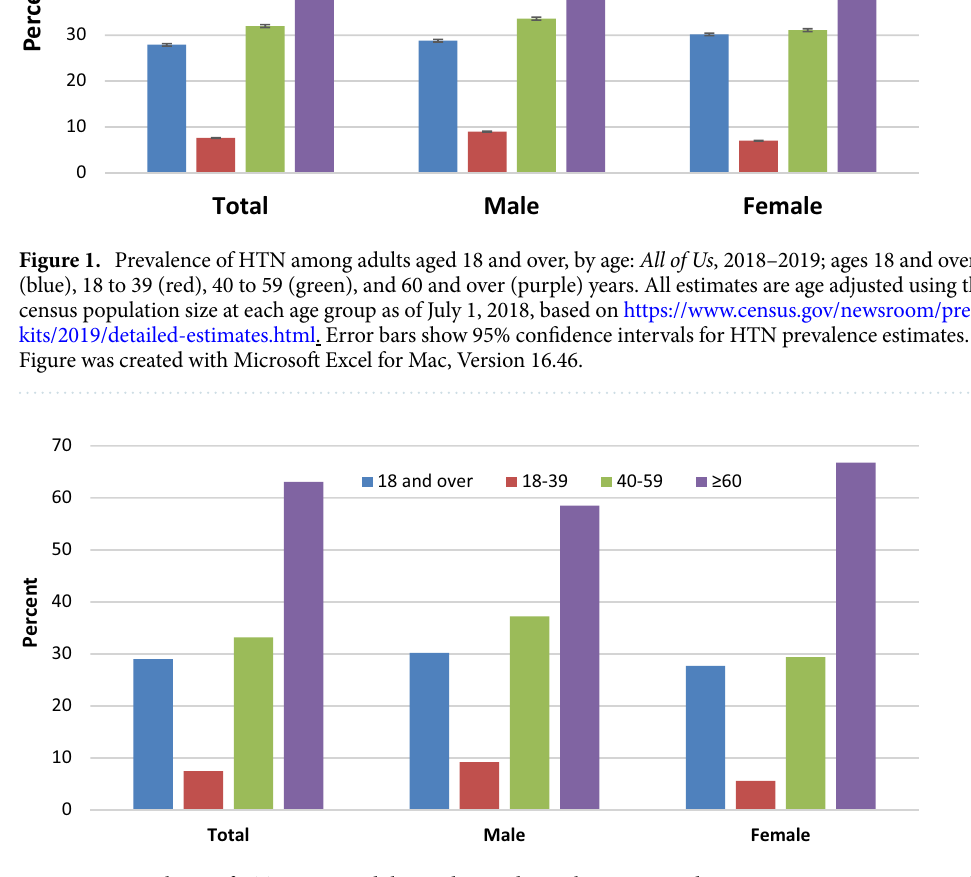
Figure 2. Prevalence of HTN among adults aged 18 and over, by age: United States, 2015–2016; ages 18 and over (blue), 18 to 39 (red), 40 to 59 (green), and 60 and over (purple) years. All estimates are age adjusted by the direct method using computed weights based on the subpopulation of persons with HTN in the 2007–2008 National Health and Nutrition Examination Survey, using age groups 18–39, 40–59, and 60 and over. Access data table for Fig. 2 at: https:// www. cdc. gov/ nchs/ data/ datab riefs/ db289_ table. pdf#4. SOURCE: NCHS, National Health and Nutrition Examination Survey, 2015–2016. Figure was created with Microsoft Excel for Mac, Version